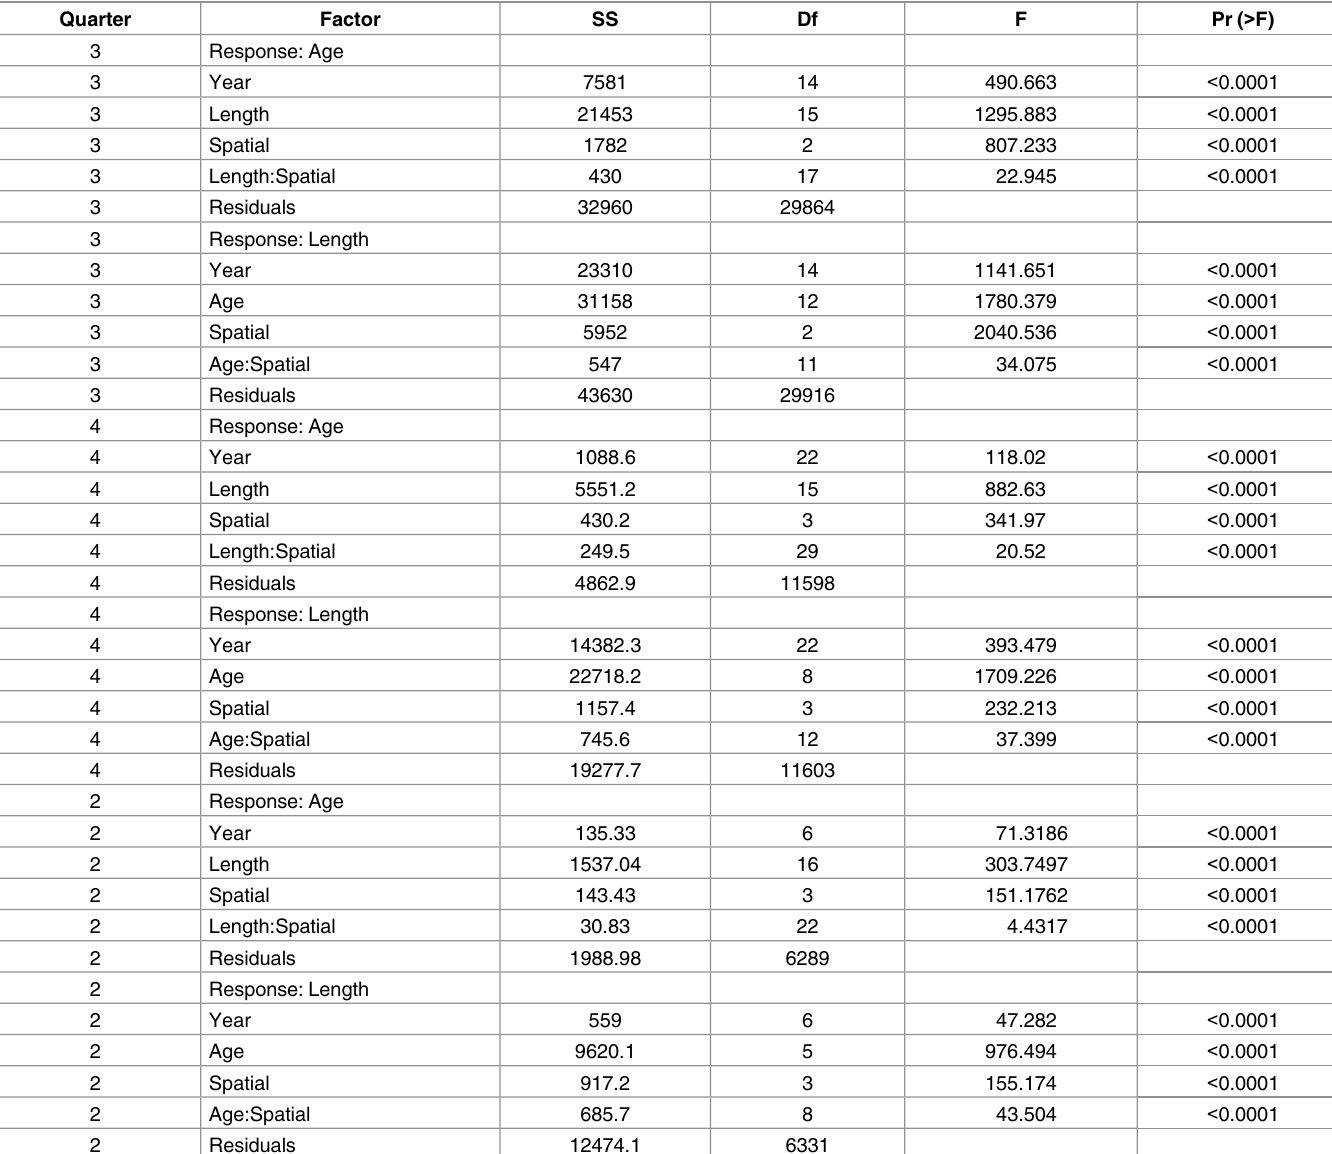
Table 1. Analysis of deviance table for age-at-length and length-at-age from generalized linear